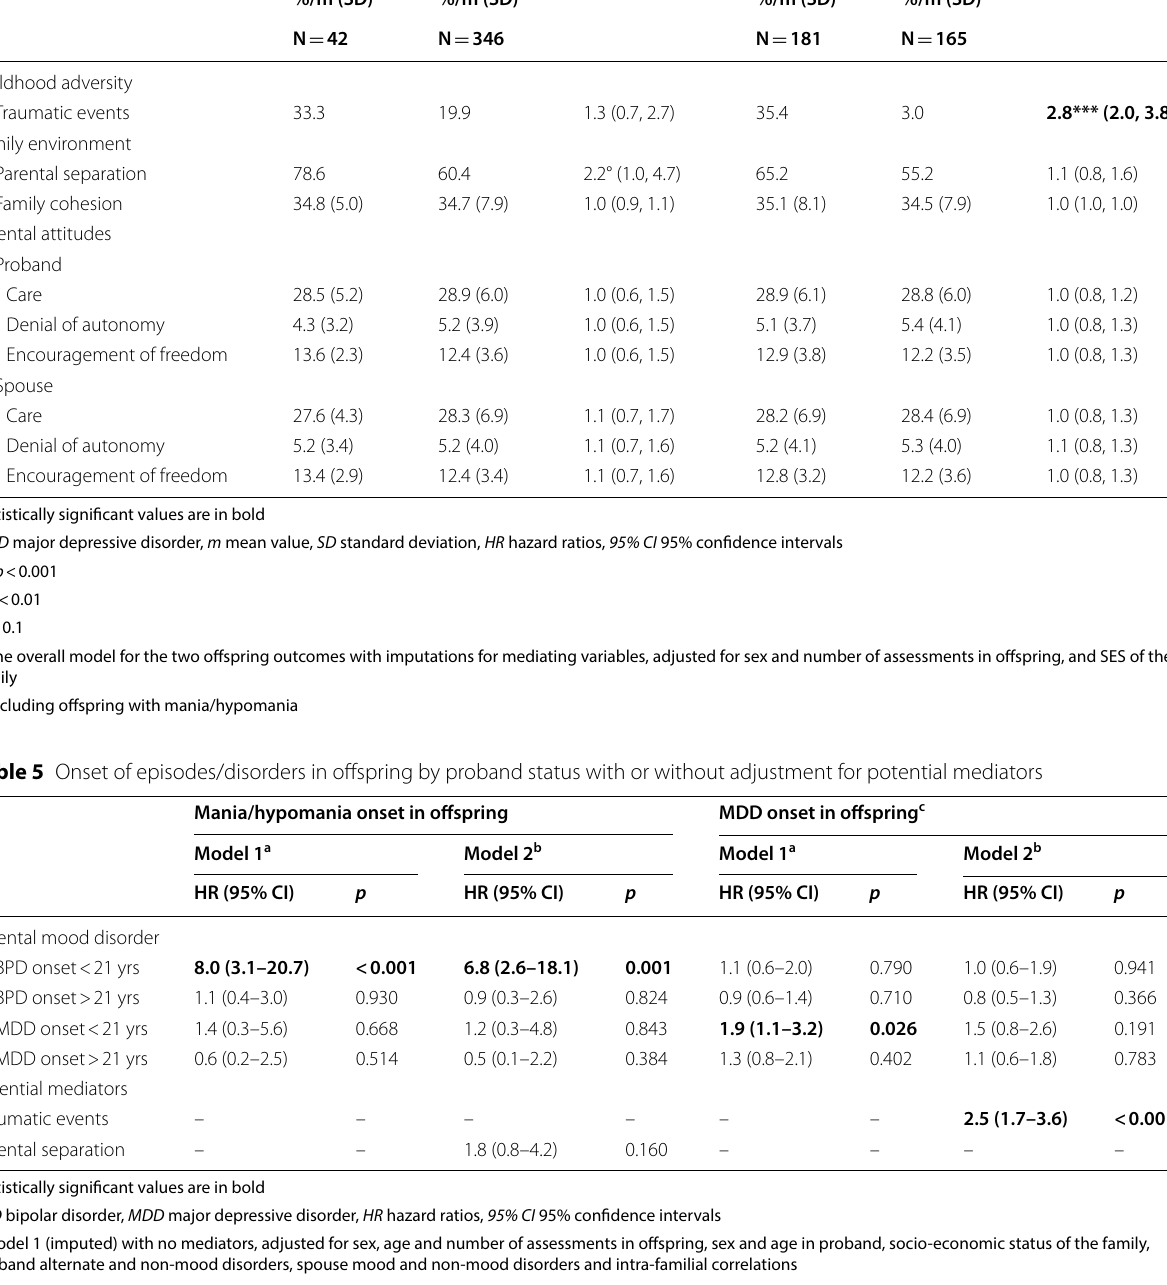
Table 4 Onset of mood episodes or disorders in offspring by preceding individual or familial environmental factors